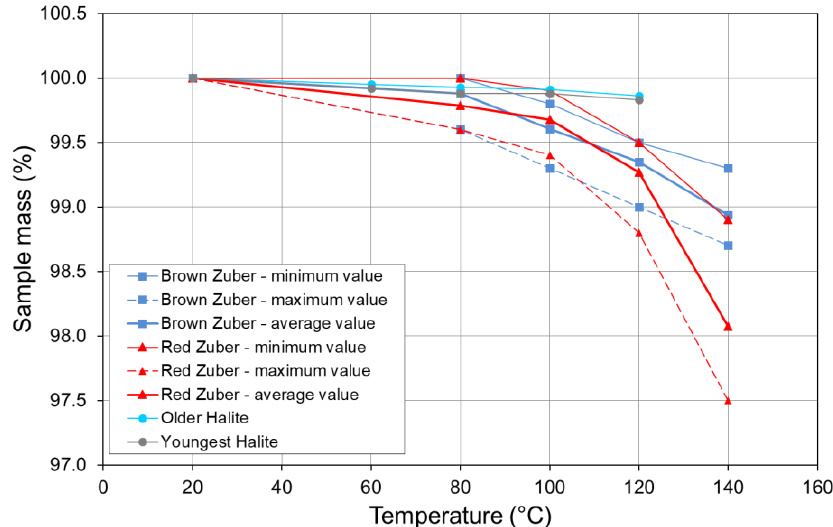
Figure 6. Zuber rock and rock salt mass loss dependence on temperature (according to [46]).